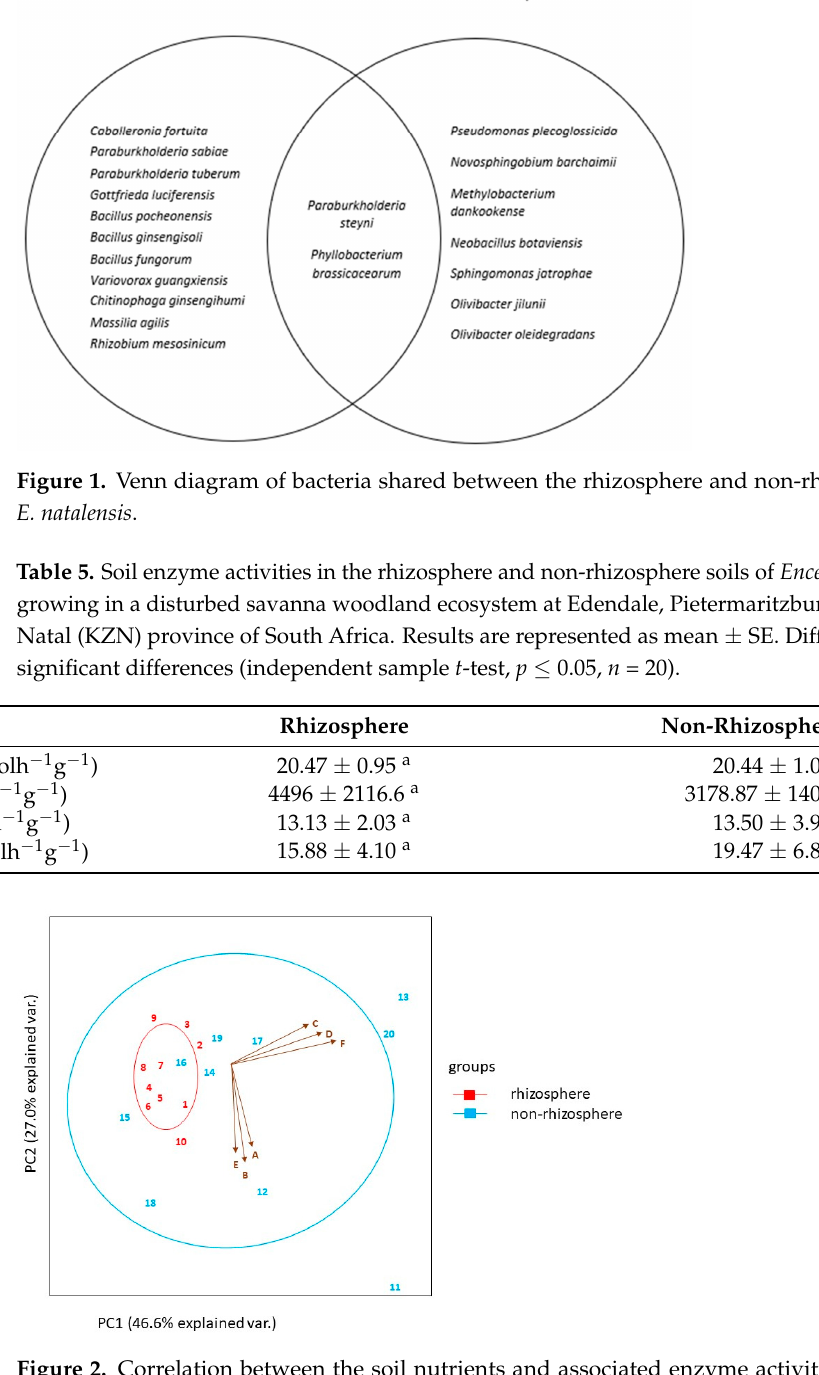
Figure 2. Correlation between the soil nutrients and associated enzyme activities of E. natalensis rhizosphere and surrounding soils. Soil characteristics are represented as follows: A = nitrate reduc- tase (µmolh − 1 g − 1 ), B = total nitrogen concentration (mg.kg − 1 ), C = acid phosphatase (nmolh − 1 g − 1 ), D = extractable phosphorus concentration (mg.kg − 1 ), E = β -(D)-Glucosaminidase (nmolh − 1 g − 1 ), F= alka- line phosphatase (nmolh − 1 g − 1 ). Principal component analysis (PCA).